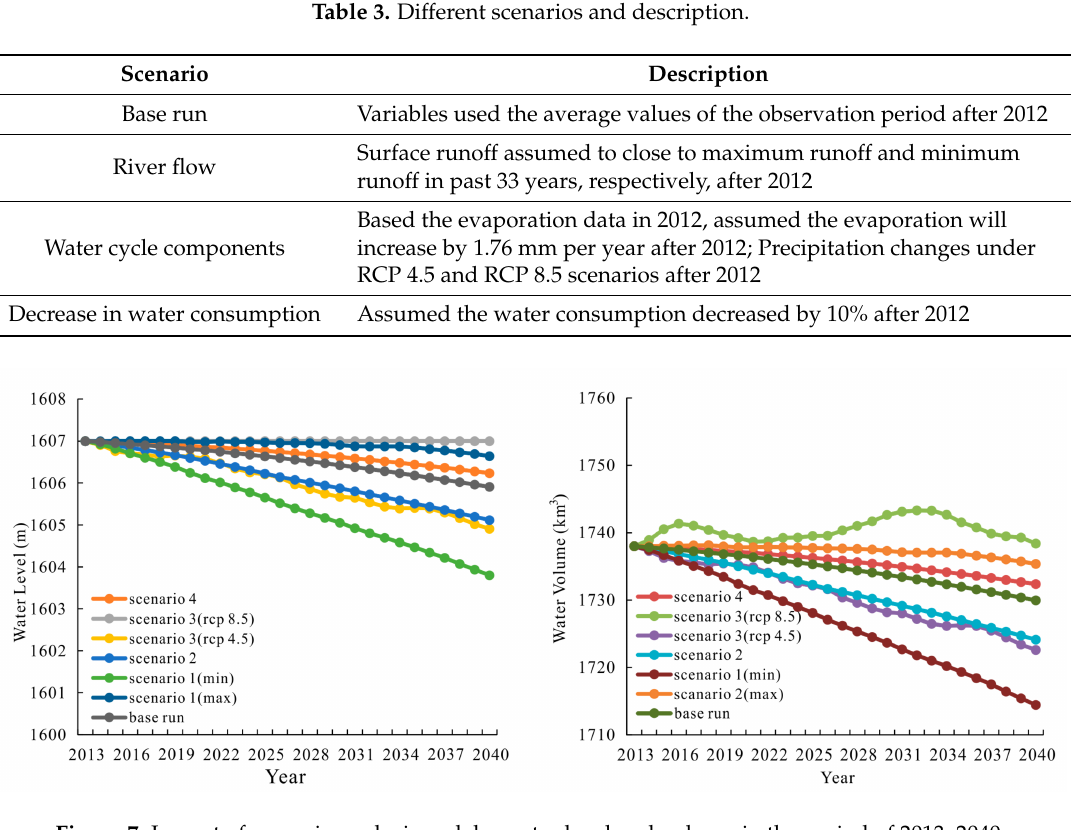
Figure 7. Impact of scenario analysis on lake water level and volume in the period of